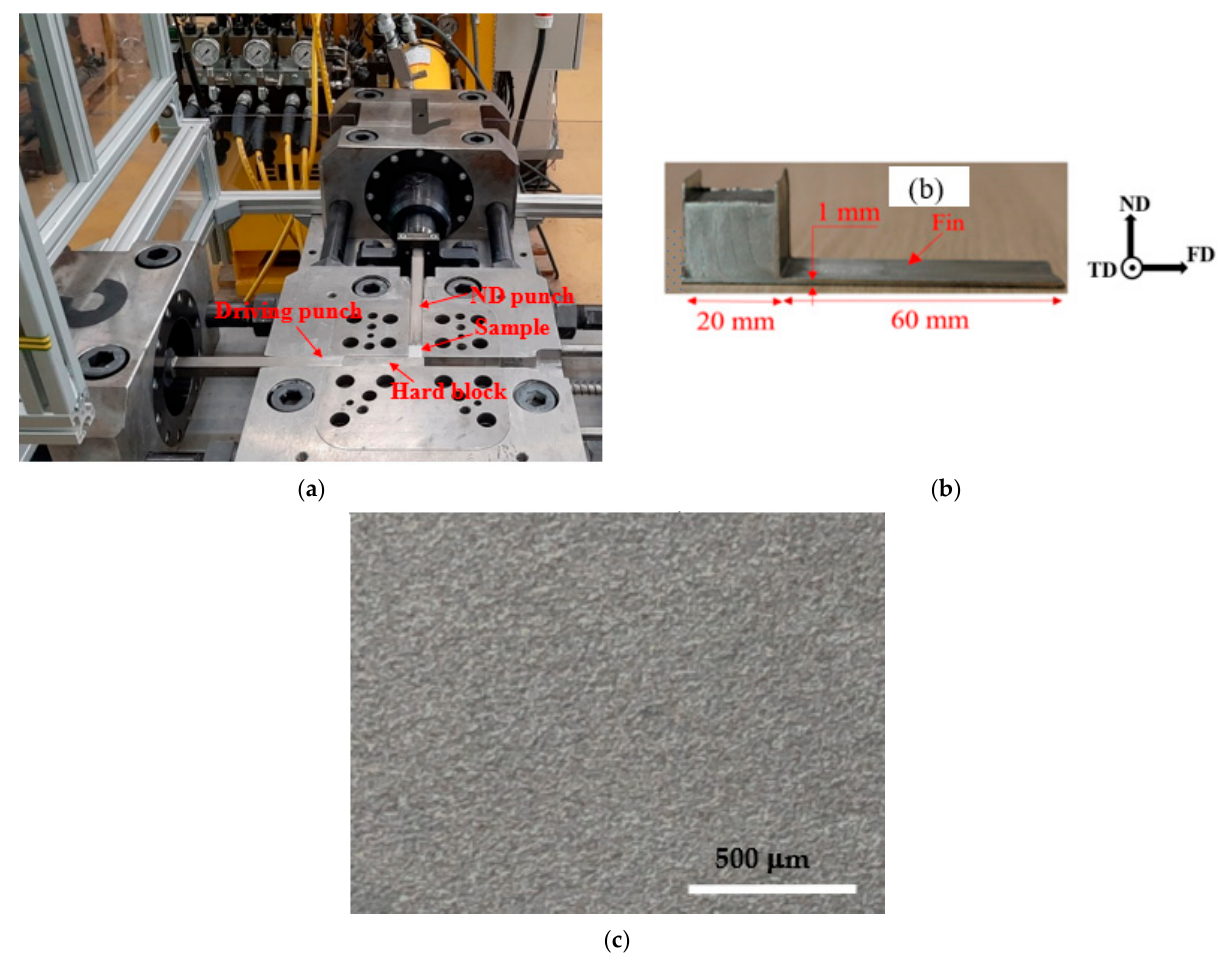
Figure 2. ( a ) Experimental setup, ( b ) an example of a partially extruded Al-1050 sample, and ( c ) an optical micrograph showing the quality of the bottom surface of the extruded sample.